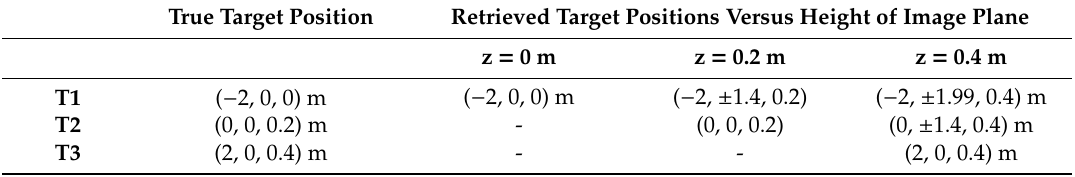
Table 5. Estimated and true target positions for di ff erent imaging